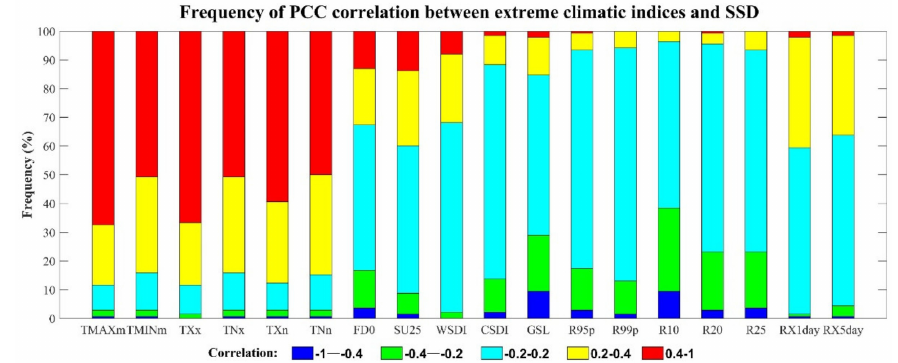
Figure 12. Statistical results of the Pearson correlation coe ffi cients of RHU with extreme climatic indices in the Loess Plateau region, where TMAXm and TMINm represent the TMAXmean and TMINmean, respectively.